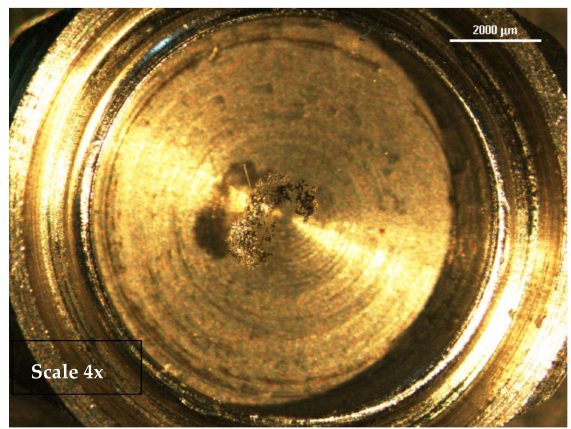
Figure 20. Upper JB after notching